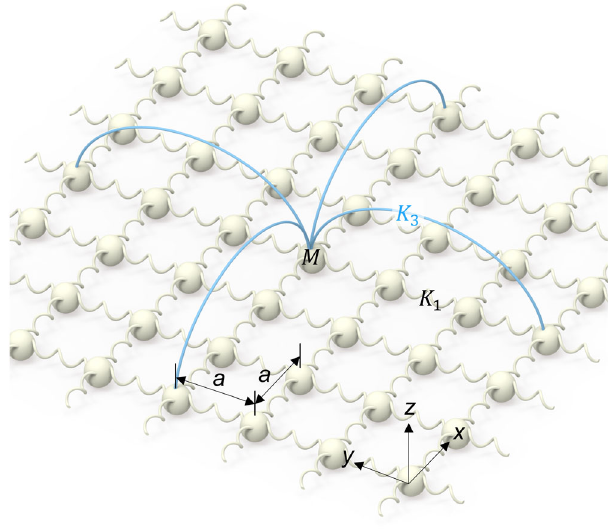
values. In Fig. 8a, red (blue) solids lines represent iso-frequency contours for the discrete system in the incidence (transmission) ¼ 0 : 7 of the region at carrier frequency ( = center frequency) ω = ω 0 Gaussian wave packed used in the numerical simulation. Dashed lines correspond to a slightly larger frequency. From two nearby iso-frequency contours, we can identify the group velocity vector v . From Snell ’ s law, one negatively refracted mode with wave g and group velocity v is expected. A snapshot of the vector k t g ¼ 150, is simulated displacement fi elds at one instant in time, t = T c shown in Fig. 8b. The interface parameters, as indicated in the fi gure, are tuned to achieve a nearly zero re fl ected partial wave. As . The dashed lines are waves move along the wave vector k t